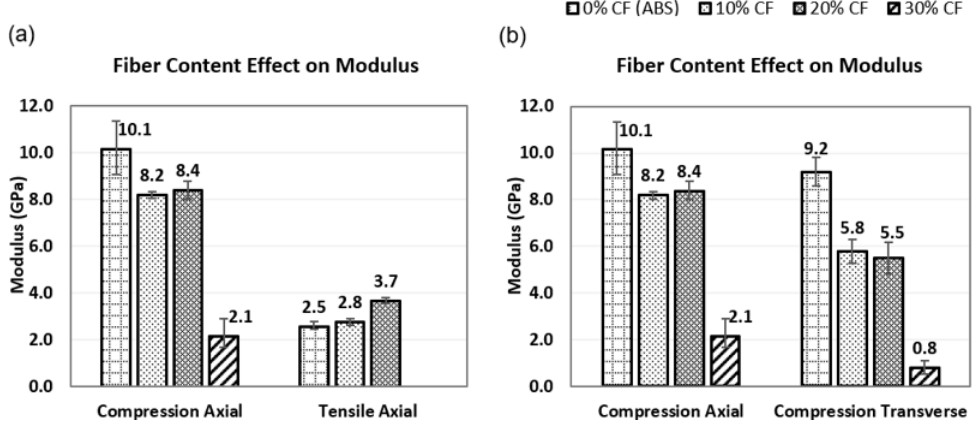
Figure 5. Fiber Content Effect on the Compressive Modulus of AM Fabricated CFRP Composites ( a ) Axial versus Transverse Compression ( b ) Axial Compression versus Axial Tensile . ( a ) Axial versus Transverse Compression ( b ) Axial Compression versus Axial